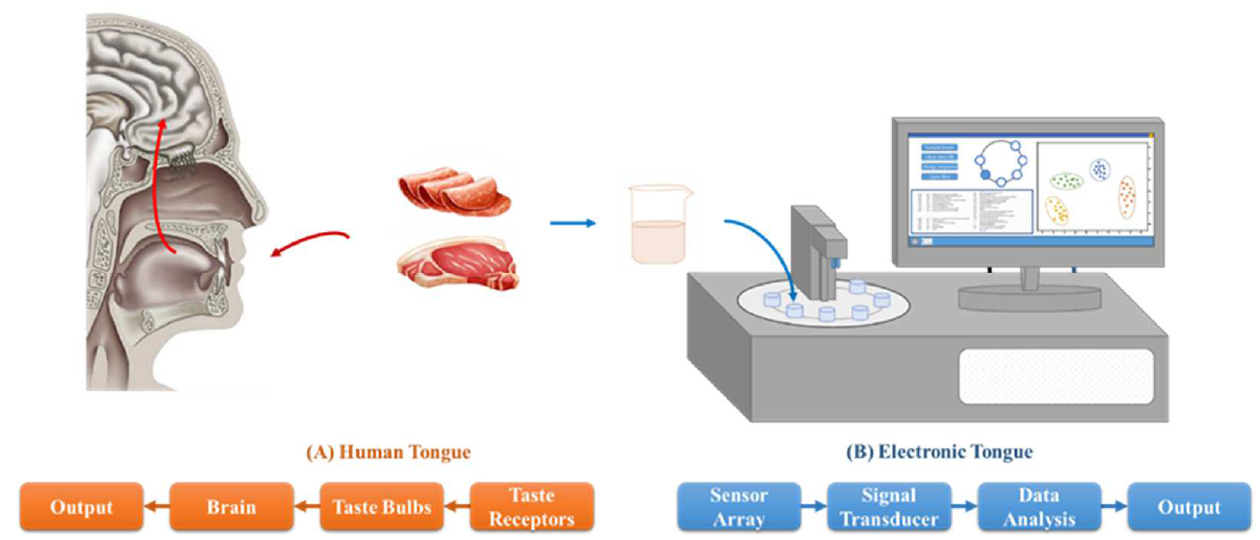
Figure 3. Schematic illustration of the biological taste system ( A ) and E-tongue technology ( B ).